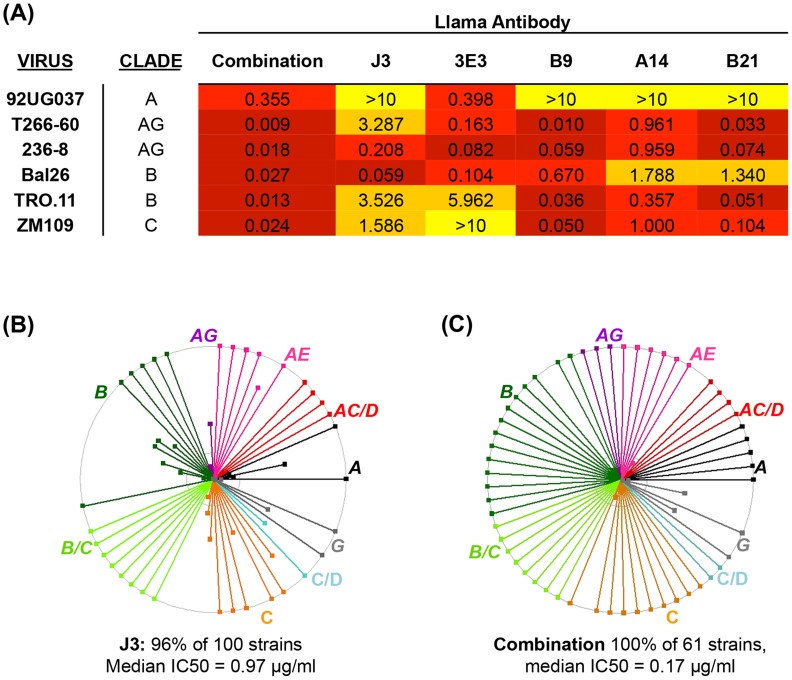
Combined breadth and potency of anti-CD4bs VHH.(A) IC50 values in µg/ml against the HIV strains indicated in the left-hand column on TZM-bl cells. VHH were titrated five-fold in duplicate both individually (from 10 µg/ml) and in combination with one another in the same plate for each virus. IC50 values of less than 0.1 are color-coded in dark red, those between 0.1 and 1 in red, those between 1 and 10 in orange and those above 10 in yellow. (B) IC50 values in µg/ml against each of the HIV strains indicated on the X-axis are shown for J3 or the combined VHH according to the color-coded legend. (C) Each spoke represents a strain of HIV neutralized by J3 or the combined VHH. Strains from different clades and CRF are color-coded according to the labels. The outer circle represents an IC50 of <1 µg/ml, the inner circle <5 µg/ml and the centre of the circle 50 µg/ml.